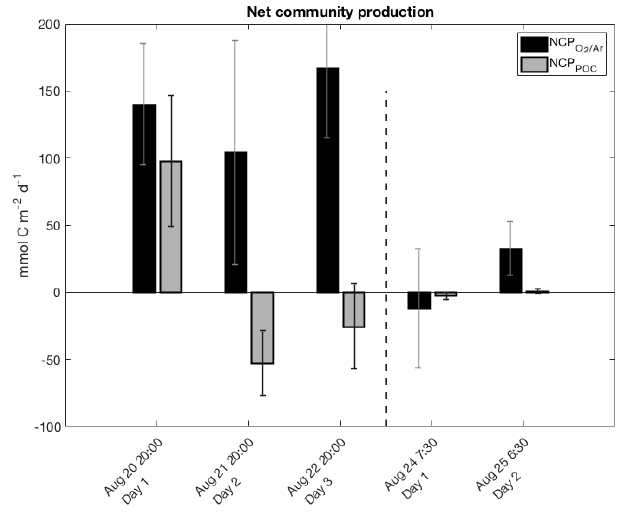
Figure 4. Daily net community production (NCP) during successive days of the two drifter deployments derived from diurnal variations of biological oxygen saturation ( (cid:49) O 2 / Ar) and particulate organic carbon (POC) concentration. Each set of bars is for one 24h pe- riod, with approximate starting times on the x axis. Note that the negative NCP O value for the first day of drifter period 2 was 2 / Ar computed by integrating NCP O values over eight consecutive 2 / Ar 3h increments (refer to Table